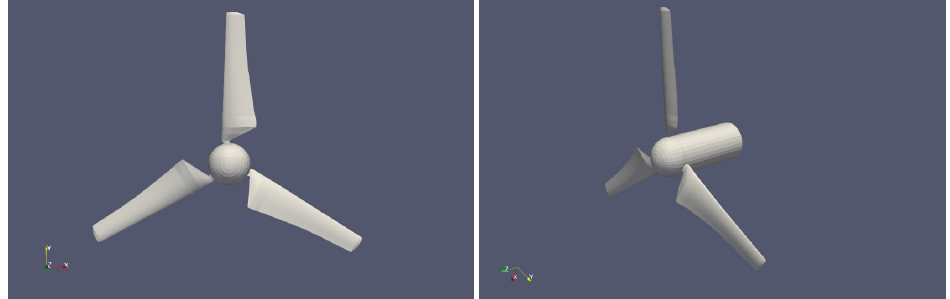
Figure 6. Three-dimensional views of the horizontal tidal turbine with a hub: front (left panel) and sideways (right panel) views.